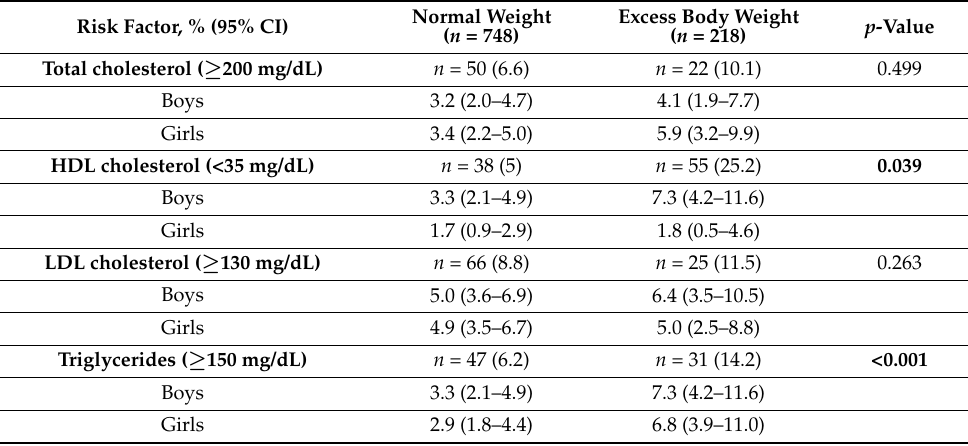
Table 3. Proportion of children with cardiometabolic risk factors by their body weight category.